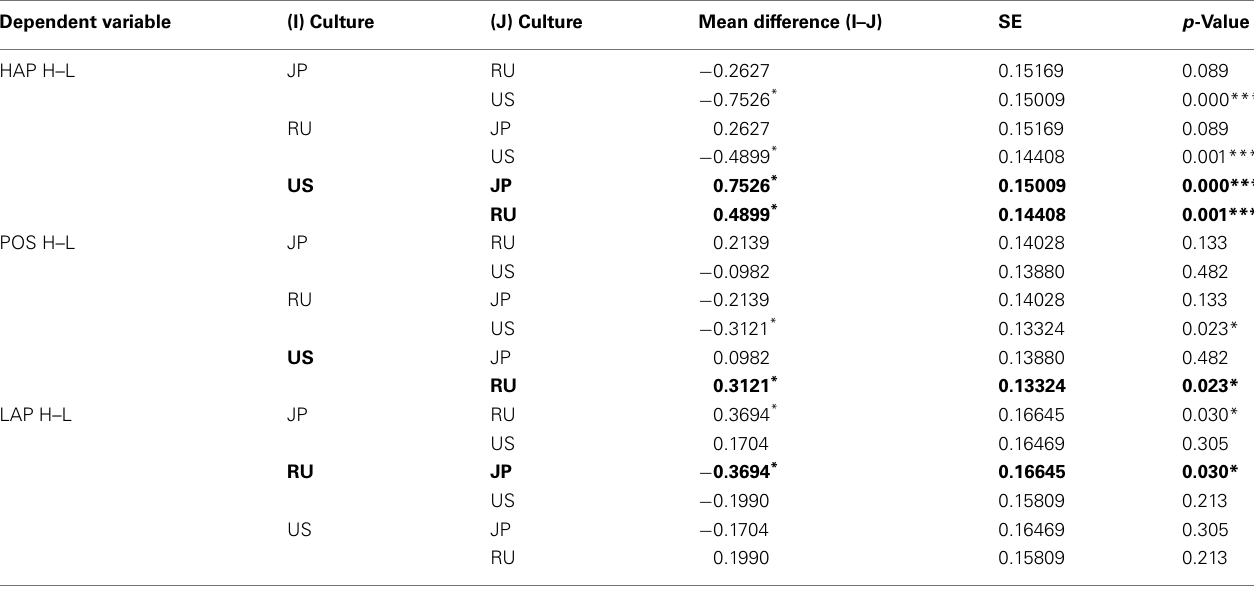
TableA9 | Post hoc comparisons of intensity difference scores from ipsatized data. Dependent